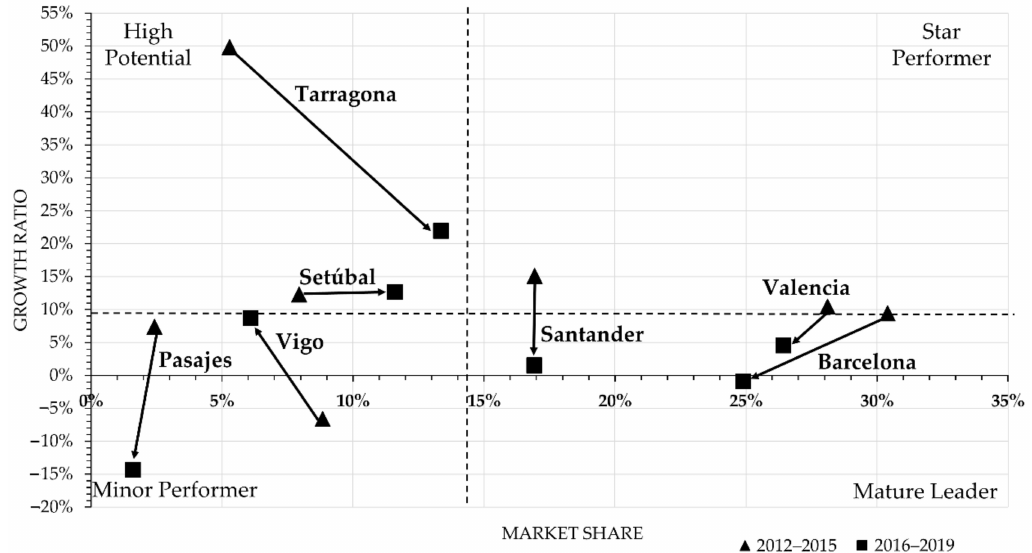
Figure 6. Matrix with dynamic portfolio analysis of port competitive positions for vehicle disembarking traffic during the period from 2012 to